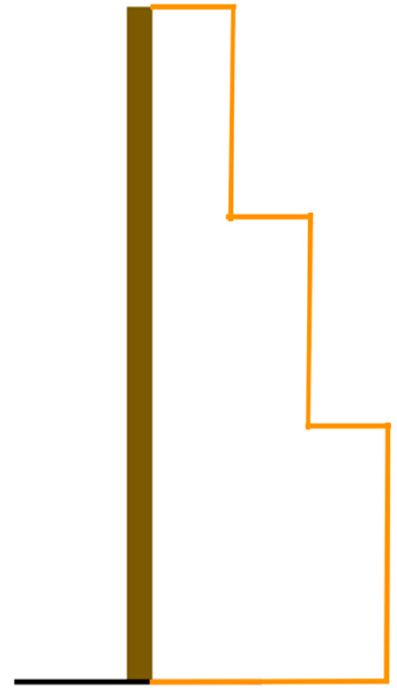
Figure A13. The 6 × 6 Compression Diagram.